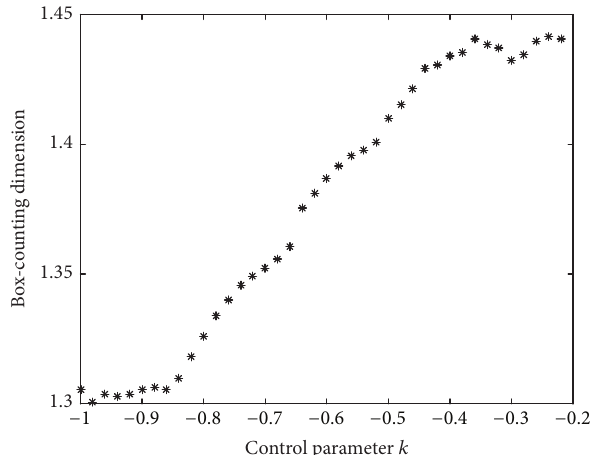
Figure 5: The change of box-counting dimensions of the Julia sets of the controlled system when 𝑘 is from − 1 to − 0.22.